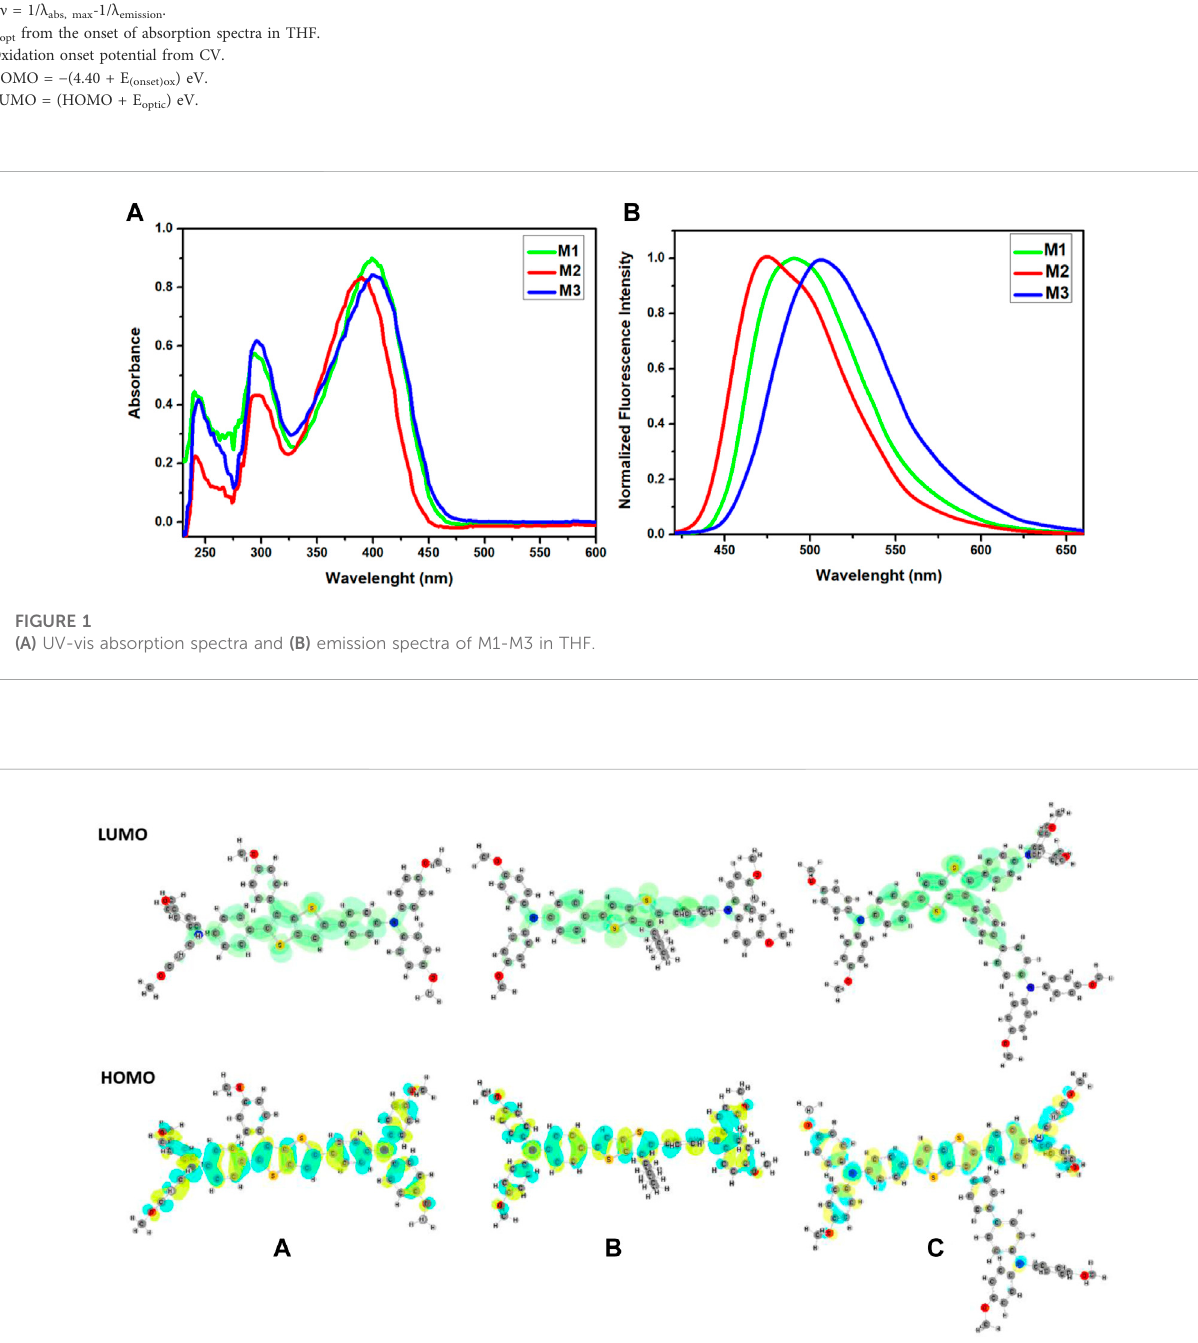
FIGURE 2 Optimized geometries (in THF) and HOMO (below) and LUMO (above) frontier orbitals of (A) M1, (B) M2, and (C) M3